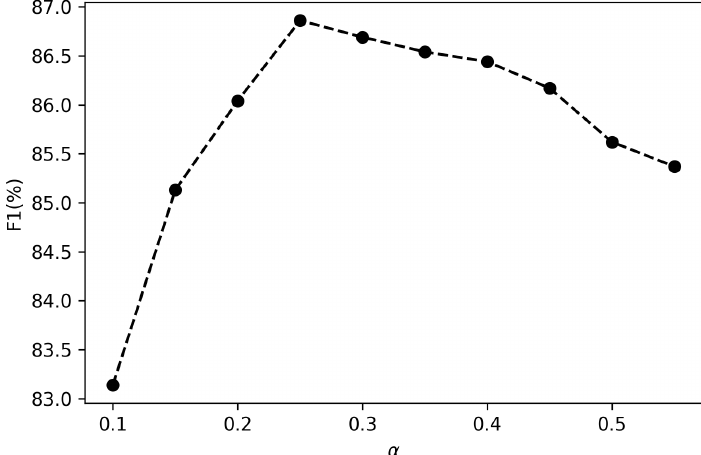
Figure 6. Line graph of α and element identification